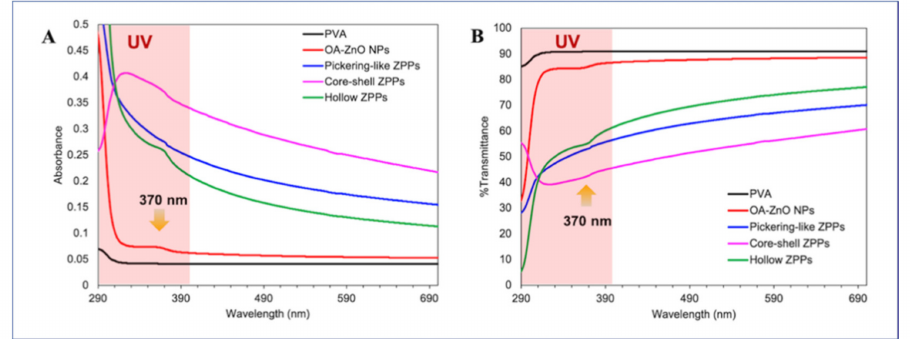
Figure 8. UV-visible absorption ( A ) and % transmittance ( B ) spectra in UV-visible range (300–700 nm) of Pickering-like, core-shell, and hollow ZPPs compared to OA-ZnO NPs. Similar results were observed in the transmission spectra as shown in Figure